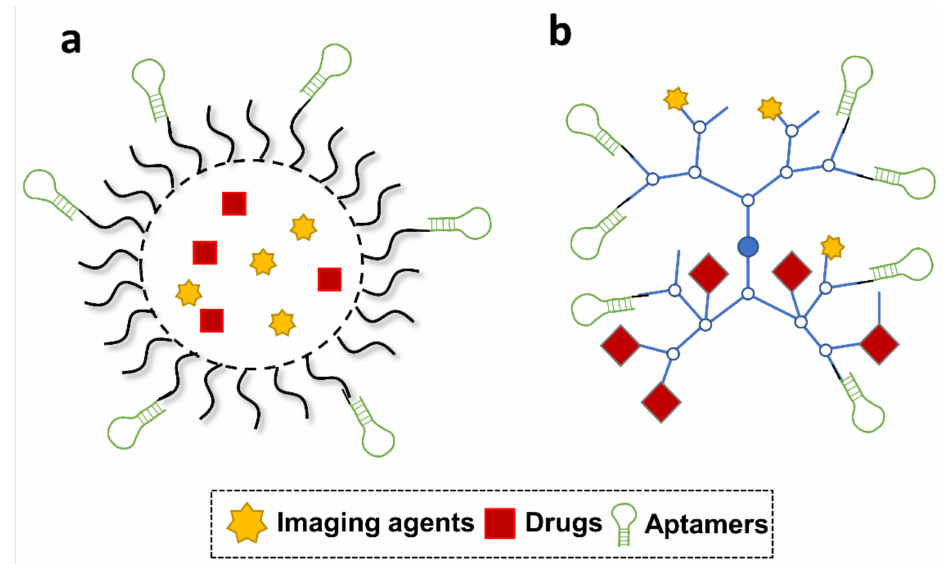
Figure 6. Schematic illustration of aptamer-functionalized polymeric nanoparticles and branched polymers. ( a ) Polymeric nanoparticles. ( b ) Branched polymeric